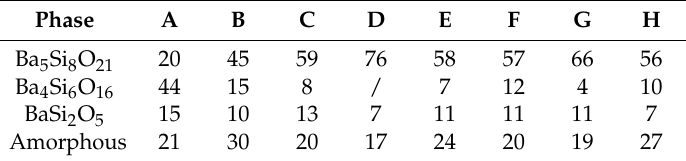
Table 3. QPA (wt.% ± 1) obtained from XRPD